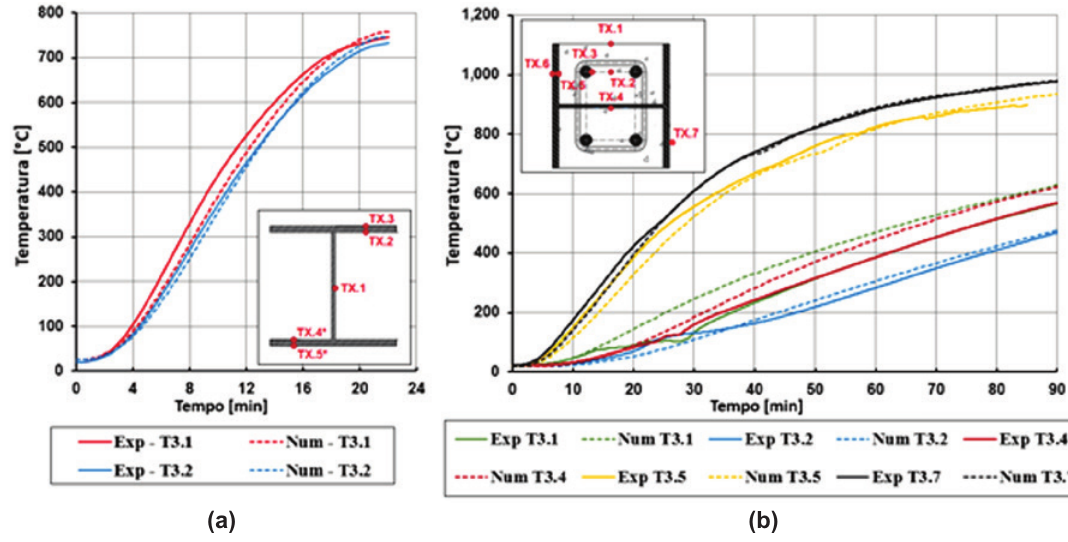
Comparação entre as temperaturas obtidas nos ensaios e numericamente para o pilar metálico (a) e misto